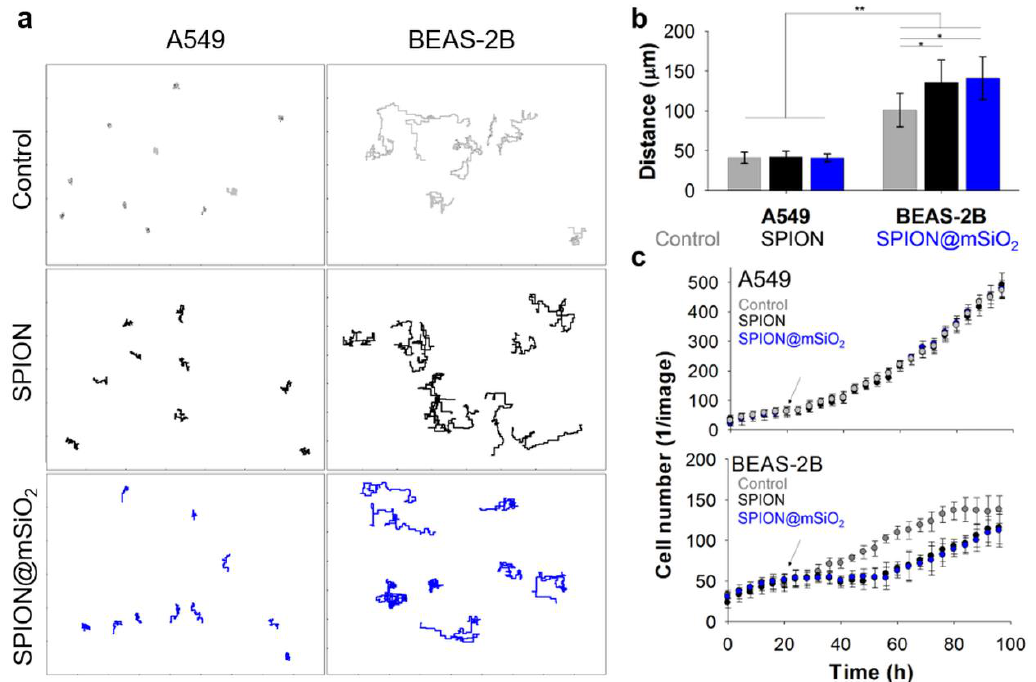
Figure 7. Line traces (after the treatment) ( a ), total distance travelled ( b ) and cell number ( c ) of A549 and BEAS-2B cells incubated with SPIONs or SPION@mSiO 2 . Statistically significant differences at * p < 0.05 and ** p < 0.001.